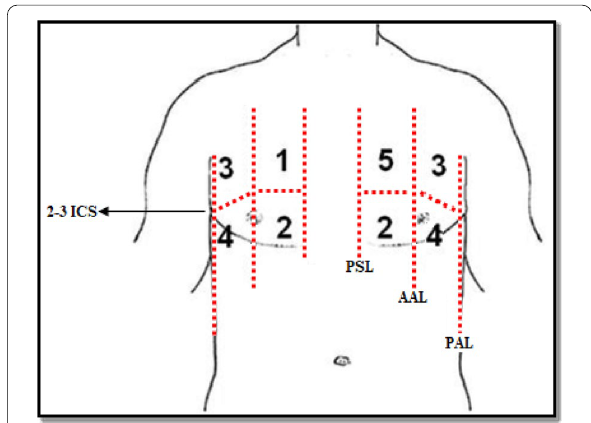
Fig. 1 The four chest ultrasound areas per side. Areas 1 and 2 denote the upper anterior and lower anterior chest areas, respectively. Areas 3 and 4 denote the upper lateral and basal lateral chest areas, respectively. PSL parasternal line, AAL anterior axillary line, PAL posterior axillary line, ICS intercostal space